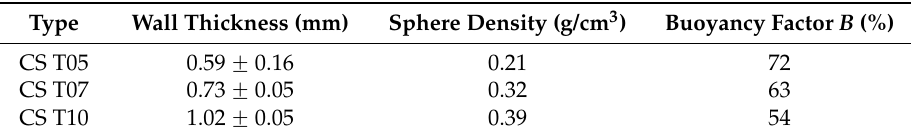
Table 2. Wall thickness, sphere density and buoyancy results of the alumina based ceramic sphere with a radius of 25